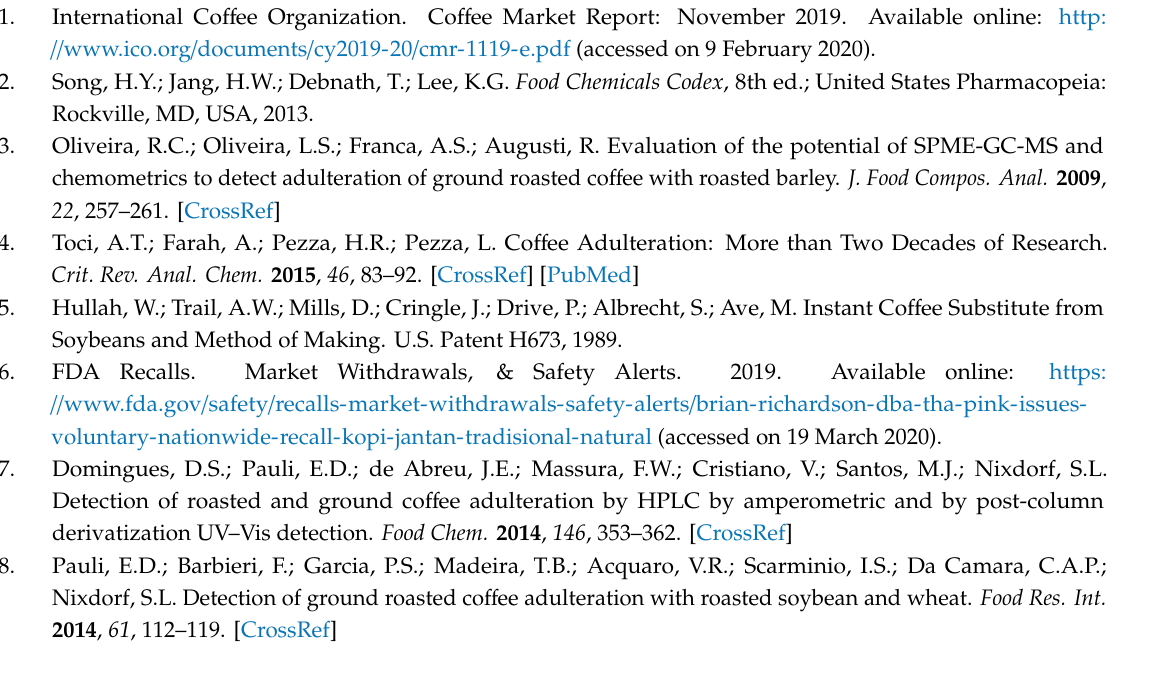
Figure S1: HPLC chromatogram of co ff ee and spent co ff ee grounds sample for 20–25 min of retention